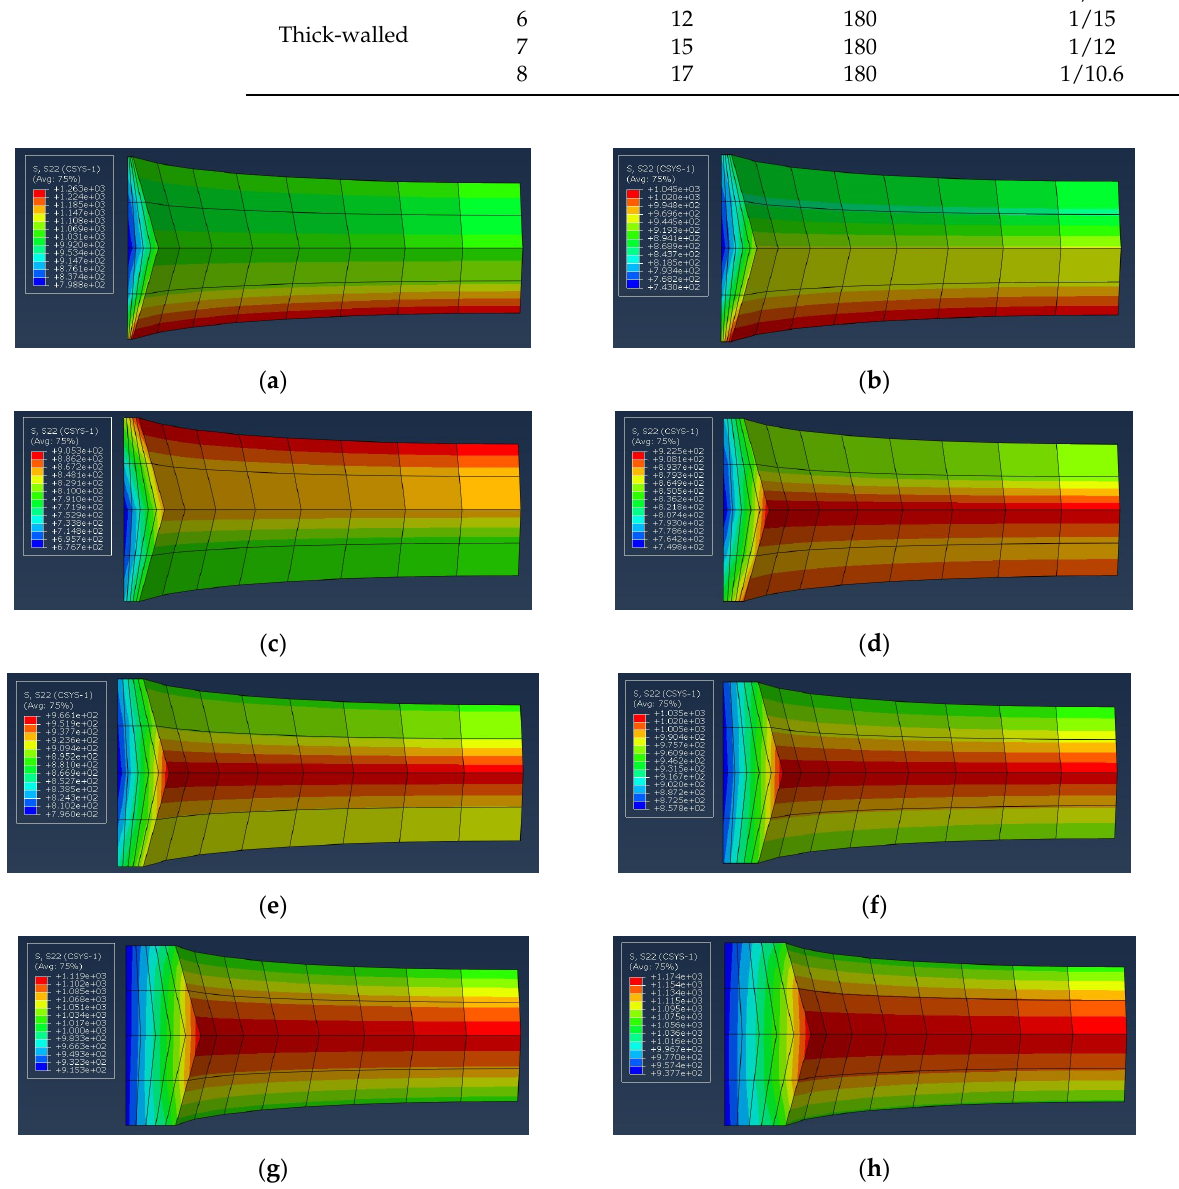
Figure 9. Annular stress contour with varying wall thickness: ( a ) group 1; ( b ) group 2; ( c ) group 3; ( d ) group 4; ( e ) group 5; ( f ) group 6; ( g ) group 7; ( h ) group 8.